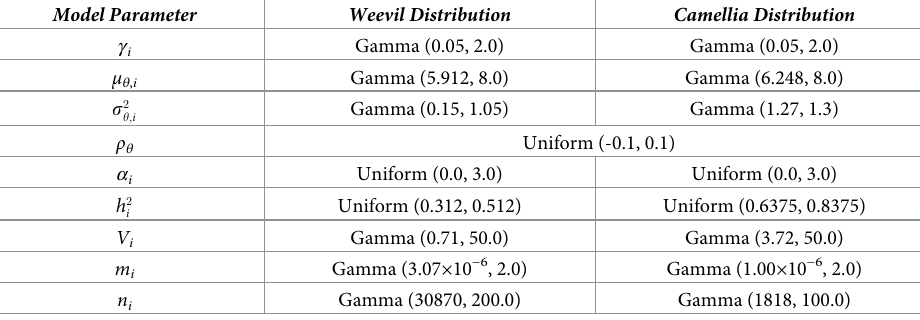
Table 4. Prior distributions for camellia and weevil